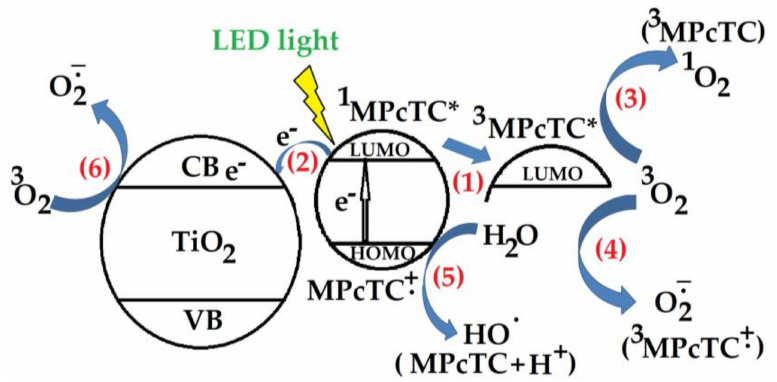
Figure 7. Mechanism for the visible light-driven generation of reactive species at the surface of the